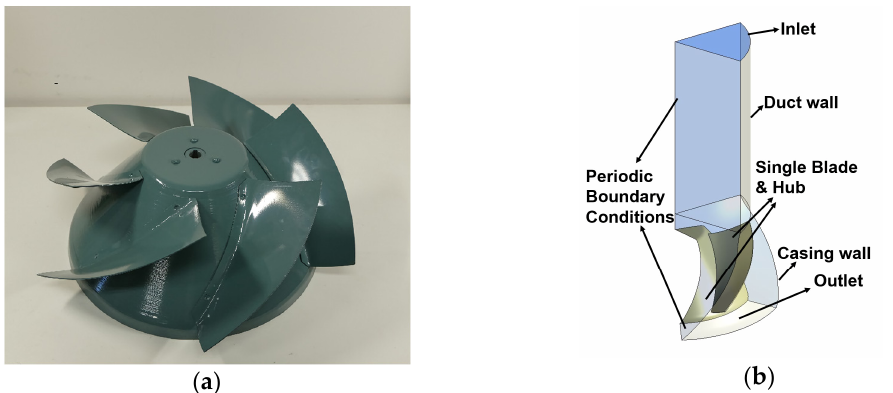
Figure 1. The basic design: ( a ) Original impeller, ( b ) Single blade numerical model.